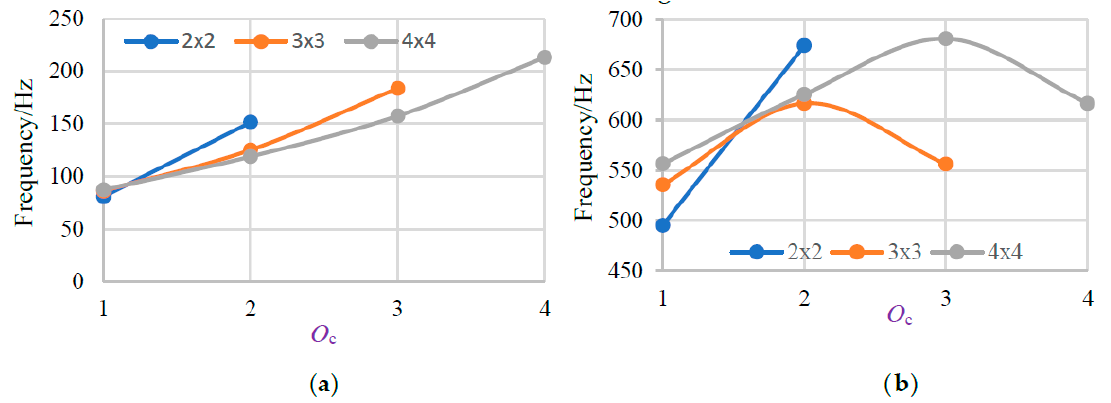
Figure 11. ( a ) The change rule of the starting frequency in associate with O c . ( b ) The change rule of the total bandwidth in associate with O c .